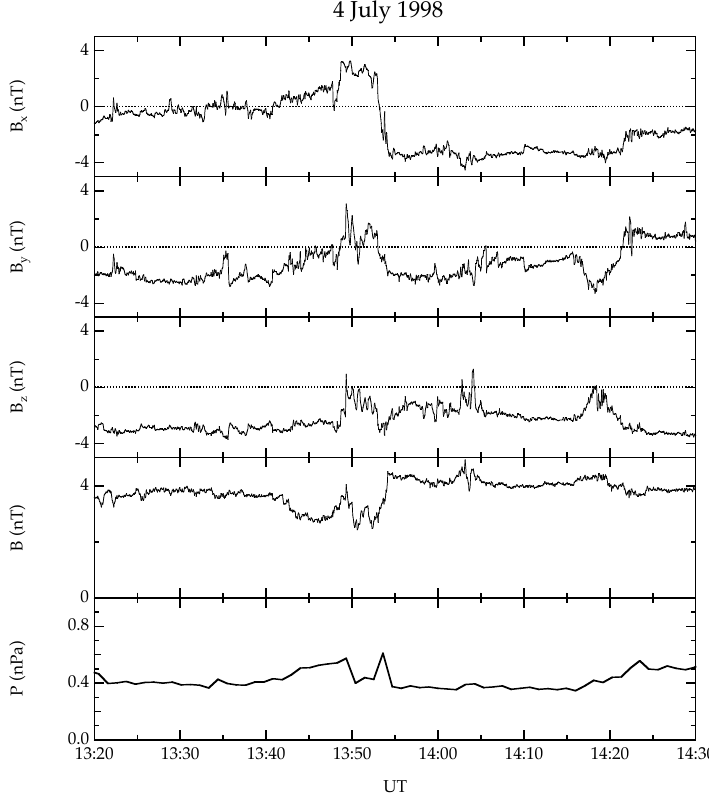
Fig. 8. Geotail dynamic pressure (nMV 2 ) and magnetic field observations in GSM coordinates from 13:20 to 14:30 UT on 4 July 1998. Geotail was located in the solar wind, where it generally observed a southward and dawnward IMF orientation. There is no evidence for a sequence of features in either the Geotail plasma or magnetic field observations that could have triggered the events at Interball-1 during the same